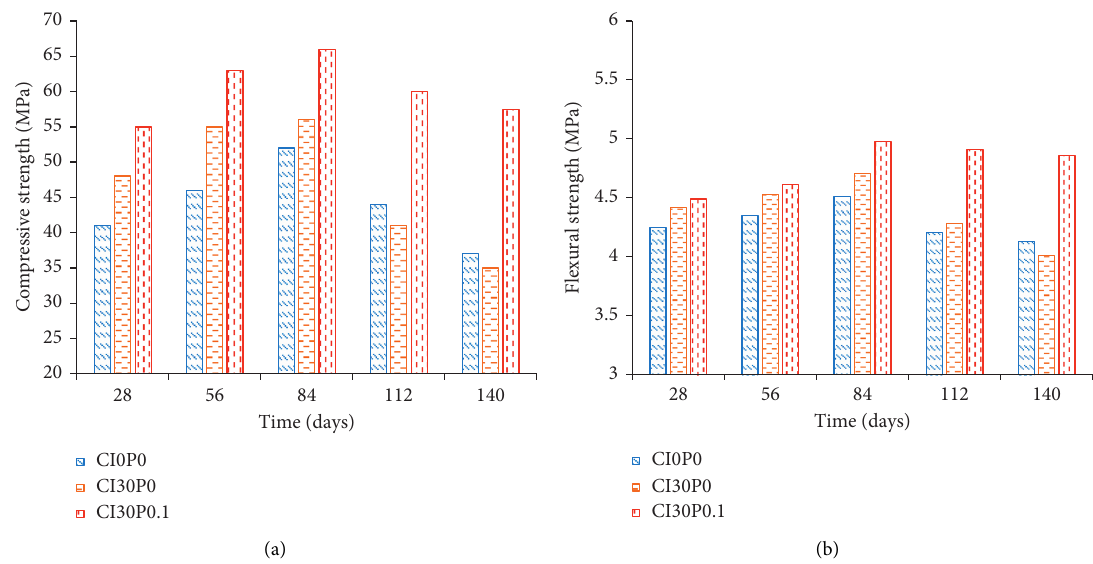
Figure 12: Compressive strength and flexural strength of the concrete. (a) Compressive strength. (b) Flexural strength.